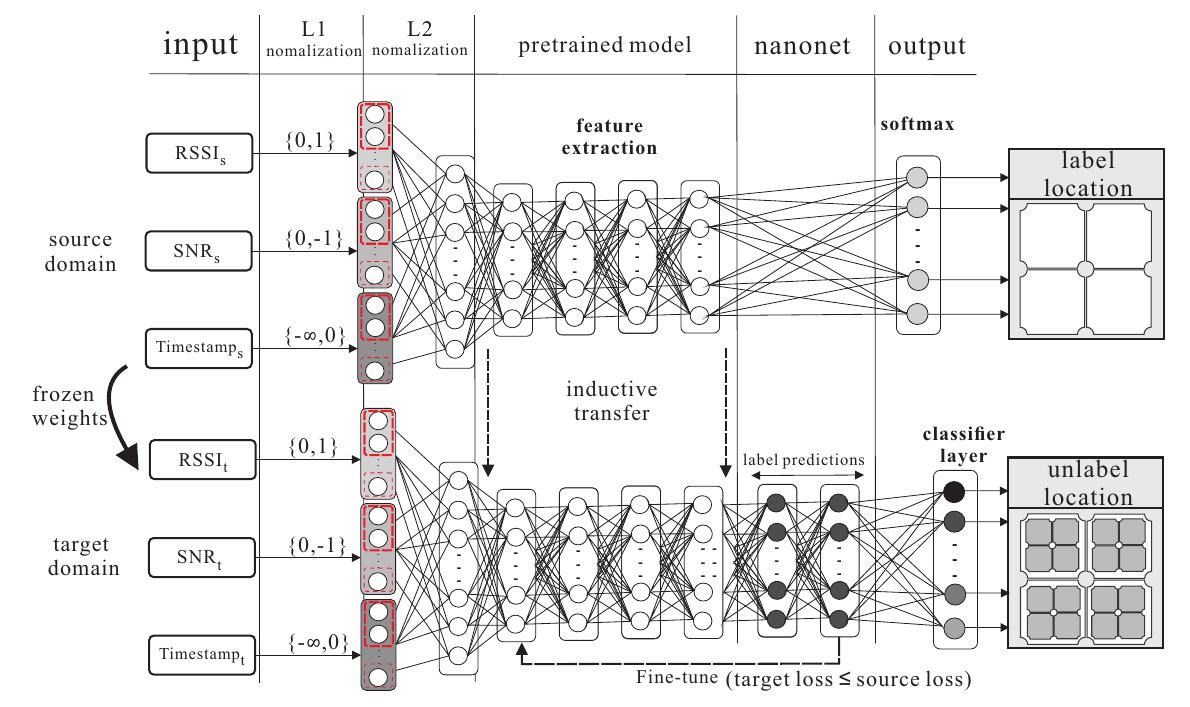
Figure 8. The kernel knowledge transferring